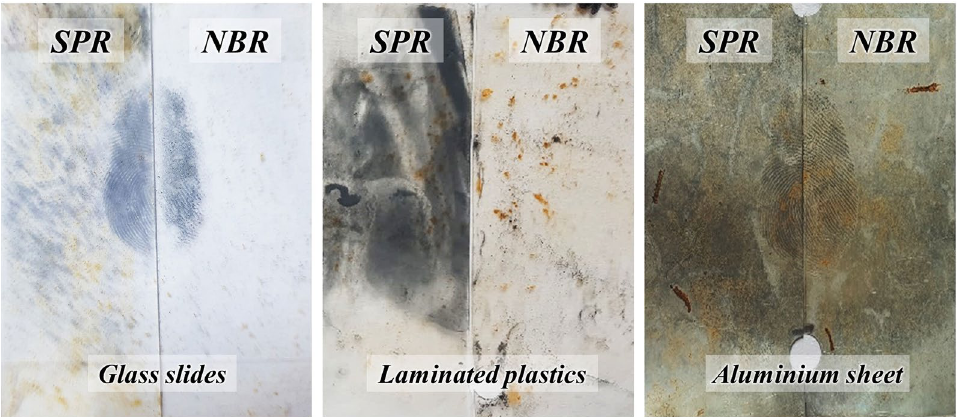
Figure 3. Representative photographs of quality of the visualised fingerprints on glass slides, laminated plastics and aluminium sheets (UC comparative scale: 0) immersed in a natural outdoor pond for four consecutive weeks.